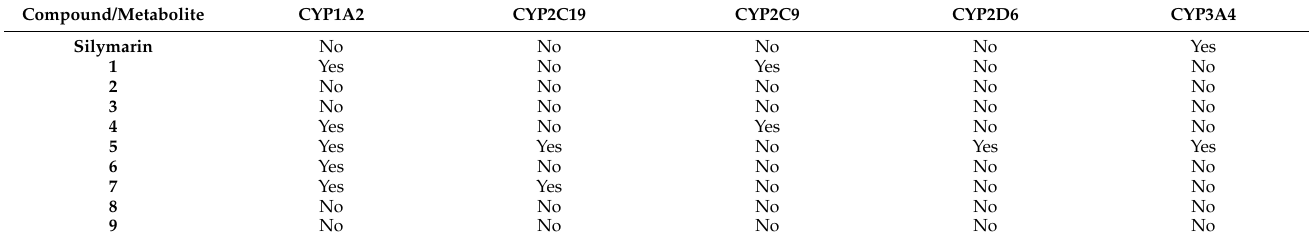
Table 5. The CYP enzymes inhibition profile for identified bioactive BERM-derived metabolites using the SwissADME web server.